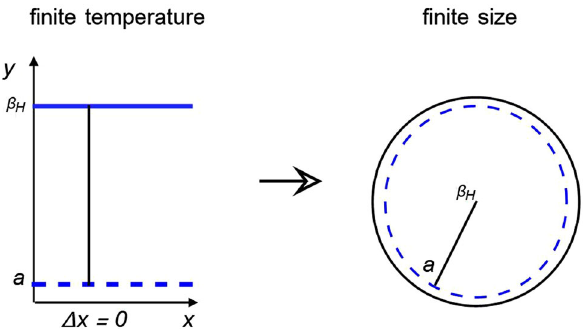
Fig. 2 The geodesic between y = a and y (cid:6) = β H at a finite temper- ature system is mapped to a finite size system, corresponding to the radius of a circle from y = a to y = L S 2